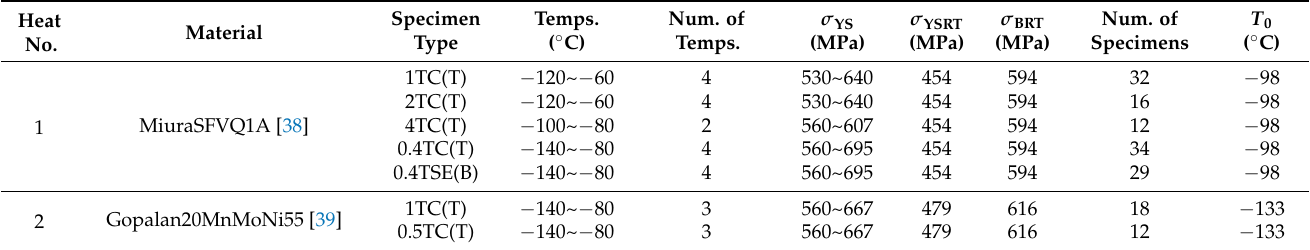
Table 2. K J c data used to construct the proposed tensile property-based MC: RPV steel ASTM A508 equivalent. Heat No.